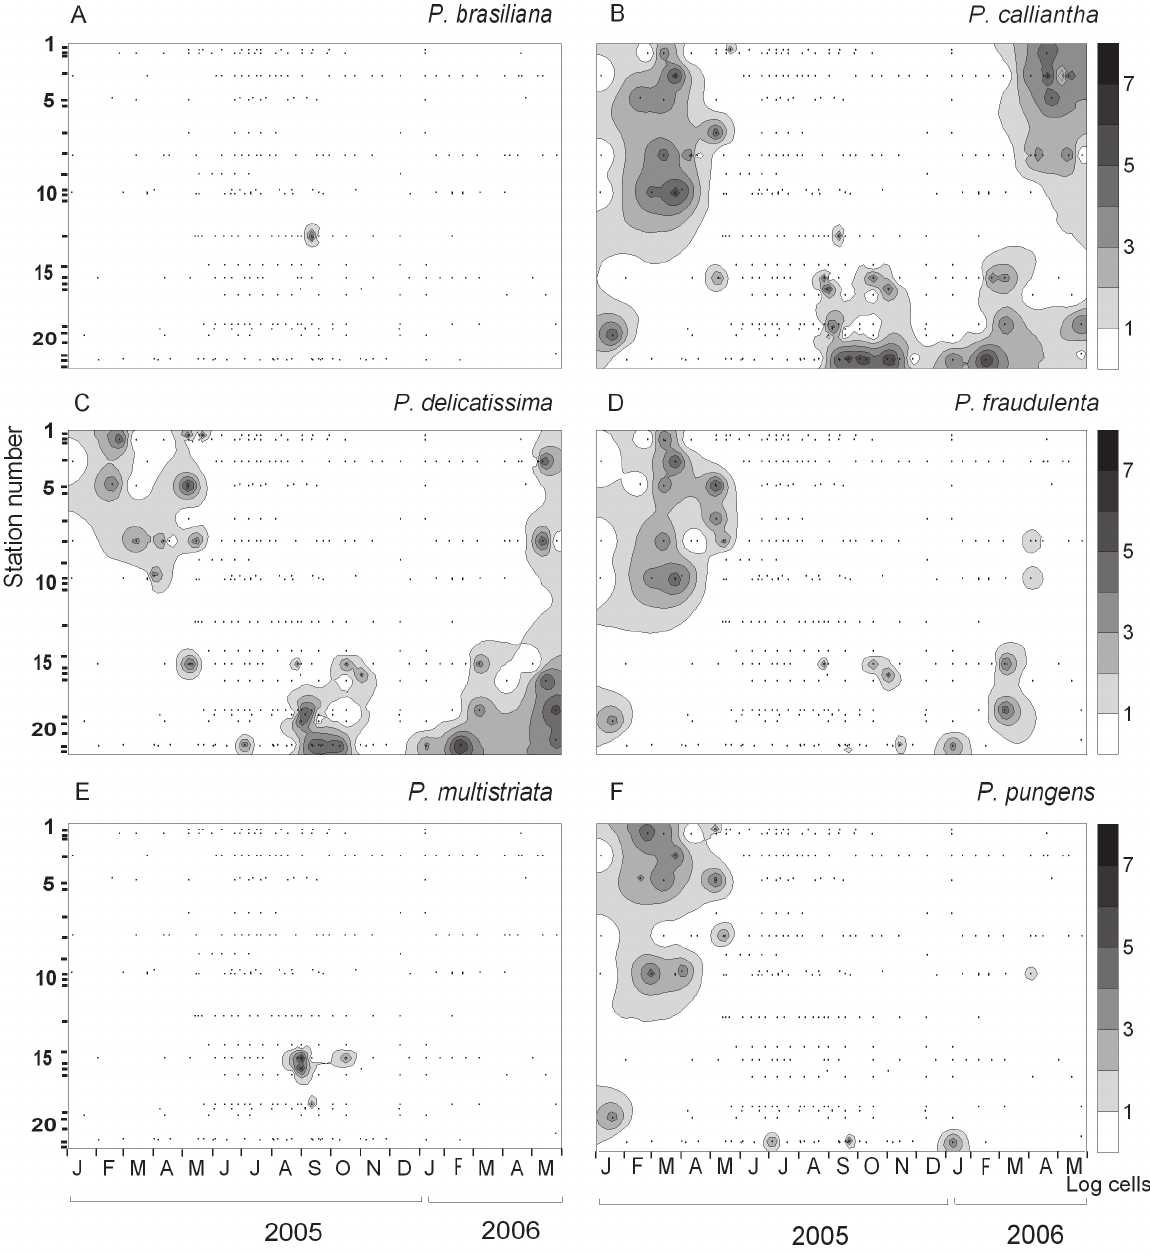
Fig . 7. – temporal-spatial distribution of the most abundant Pseudo-nitzschia